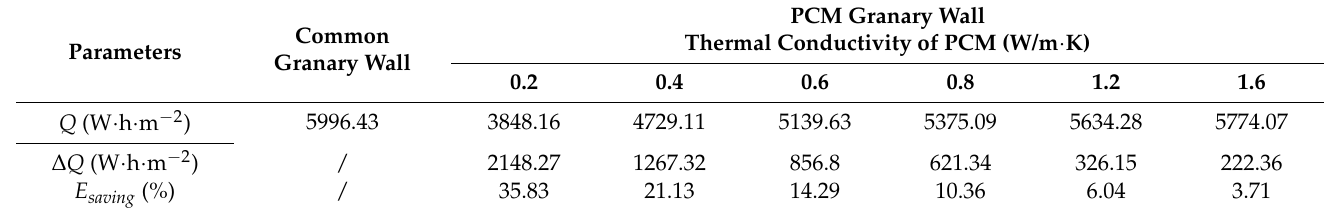
Table 2. Cooling load and energy saving rate for the PCM granary